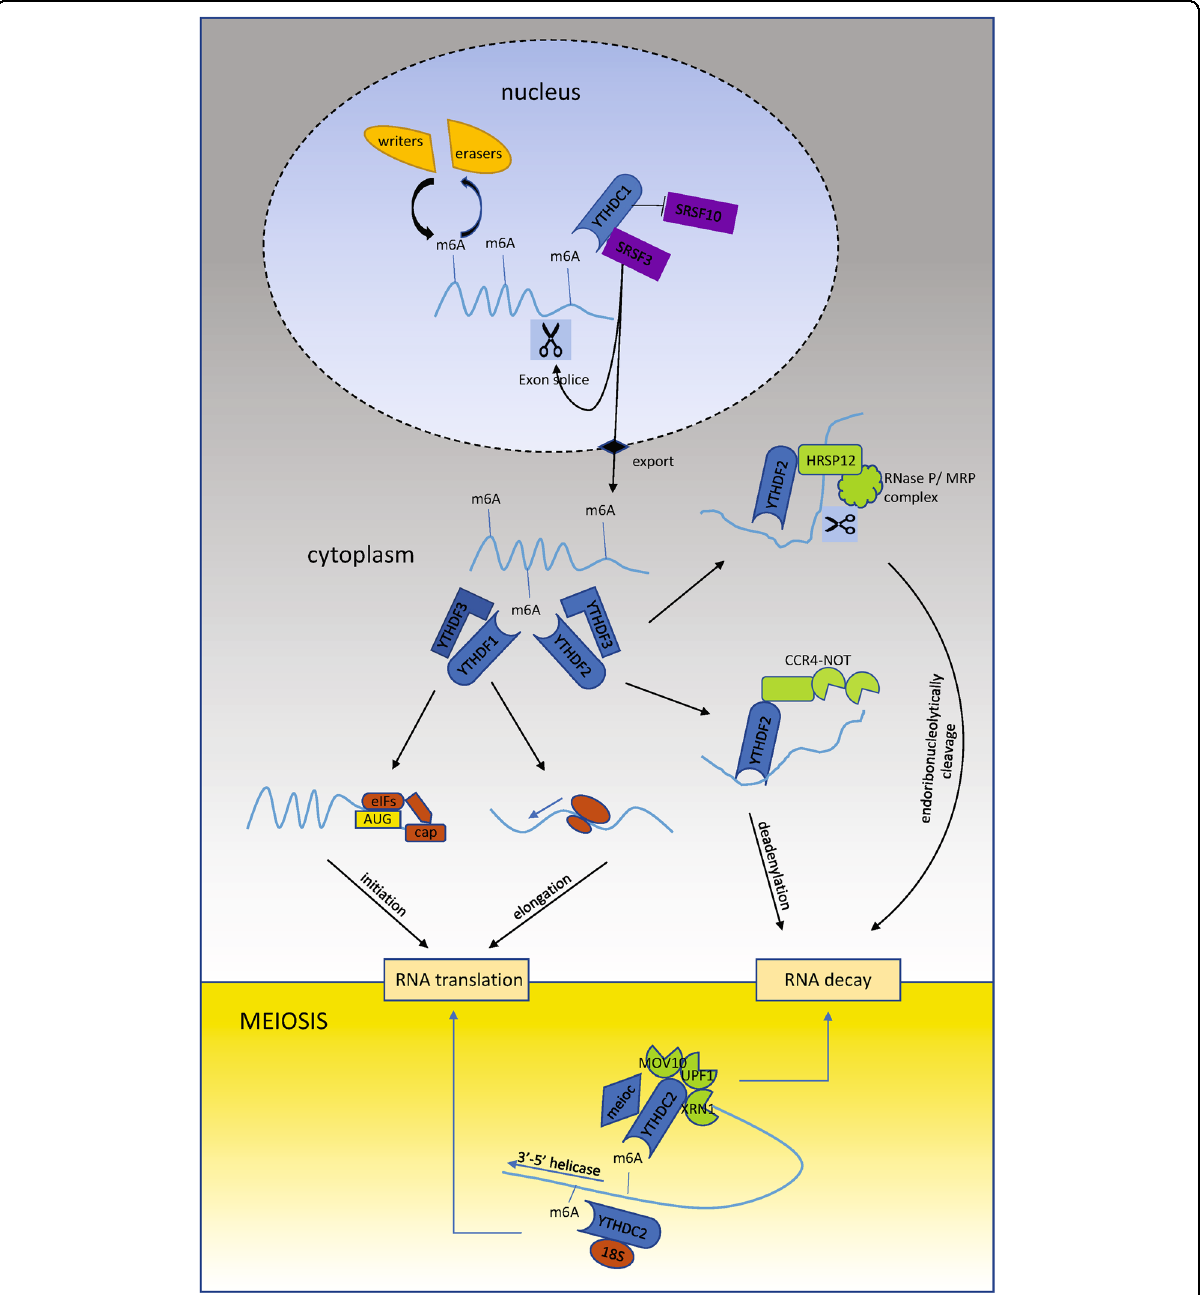
Fig. 1 Model of YTH family proteins modulating m6A-containing RNAs. In cell nucleus, “ writers ” and “ erasers ” add and remove m6A modi fi cations to and from RNA. YTHDC1 regulates splicing and mediates the export of m6A-containing mRNAs by recruiting SRSF3, while blocking SRSF10 mRNA binding. In cytoplasm, YTHDF1 recognizes m6A-containing mRNAs and promotes its translation initiation and elongation. And the m6A-containing mRNAs can also be recognized by YTHDF2, which promotes their degradation through two pathways, CCR4-NOT complex- mediated deadenylation and HRSP12-mediated endoribonucleolytic cleavage. YTHDF3 interacts with YTHDF1 and YTHDF2 to accelerate metabolism of m6A-modi fi ed mRNAs. YTHDC2 mainly functions to regulate the switch from mitosis to meiosis by interacting with MEIOC. YTHDC2 interacts with XRN1, UPF1, and MOV10 to destabilize its target RNAs. Also, the binding of YTHDC2 to the 18S rRNA and its 3 ′ -5 ′ RNA helicase activity facilitates the translation of its target